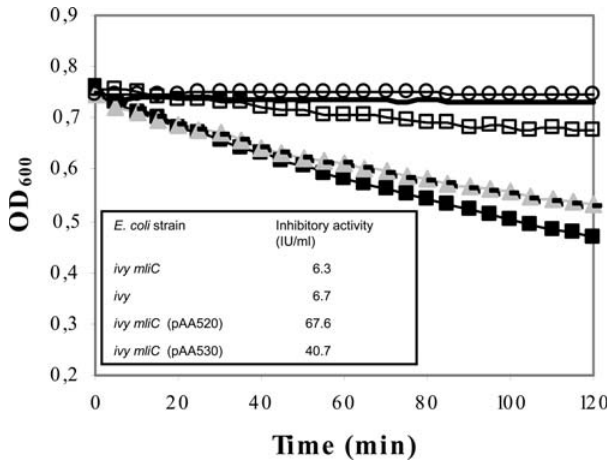
Figure 5. In vitro HEWL inhibitory activity of MliC from P. aeruginosa and E.coli . Lysis (expressed as OD 600 against time) of M. lysodeikticus cell suspension by 6.6 U/ml HEWL in the absence (- & -) and presence of membrane protein extracts of E. coli ivy mliC (1:2 diluted; - m -), E. coli ivy (1:2 diluted; —), E. coli ivy mliC (pAA520) expressing MliC from P. aeruginosa (1:10 diluted; - % -) and E. coli ivy mliC (pAA530)